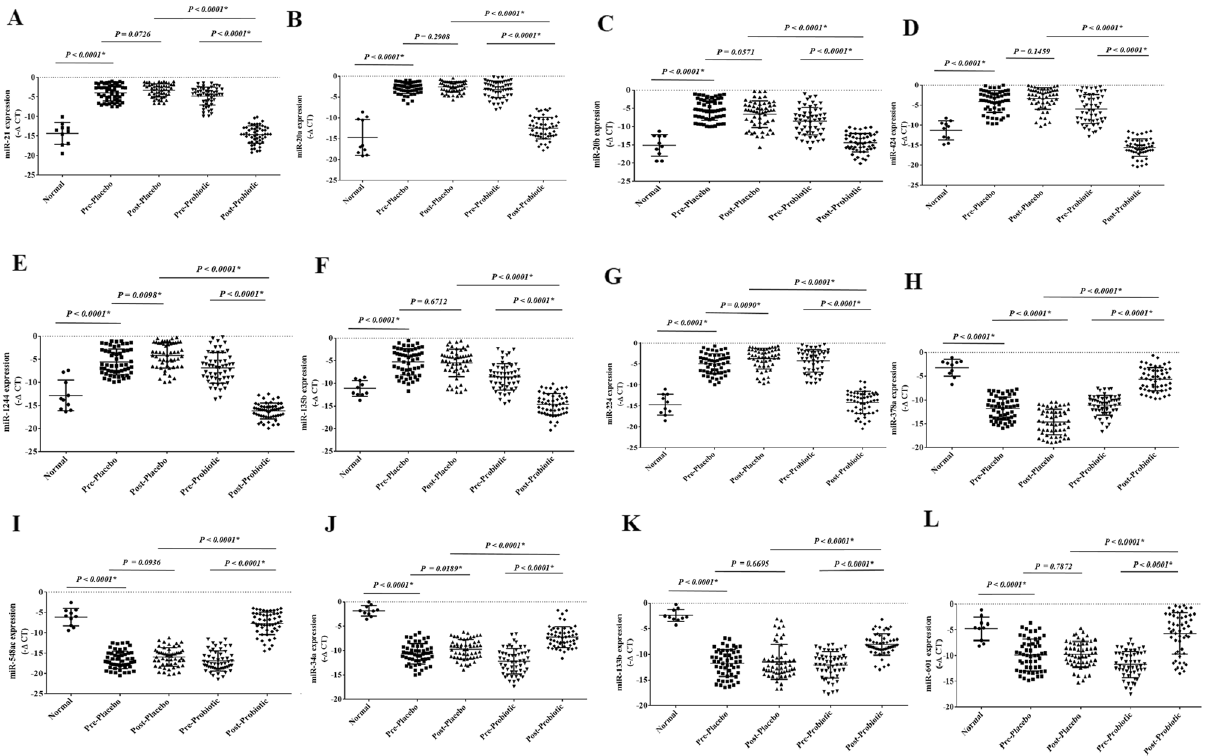
Figure 7 . The relative expression of the selected miRs in the rectal cancer patients. The relative expression levels of the miRs were normalized by using a reference RNA. The oncomiRs included: ( A ) miR-21, ( B ) miR-20a, ( C ) miR-20b, ( D ) miR-424, ( E ) miR-1244, ( F ) miR-135b, and ( G ) miR-224. Tumor suppressor miRs included: ( H ) miR-378a, ( I ) miR-548ac, ( J ) miR-34a, ( K ) miR-133b, and ( L )